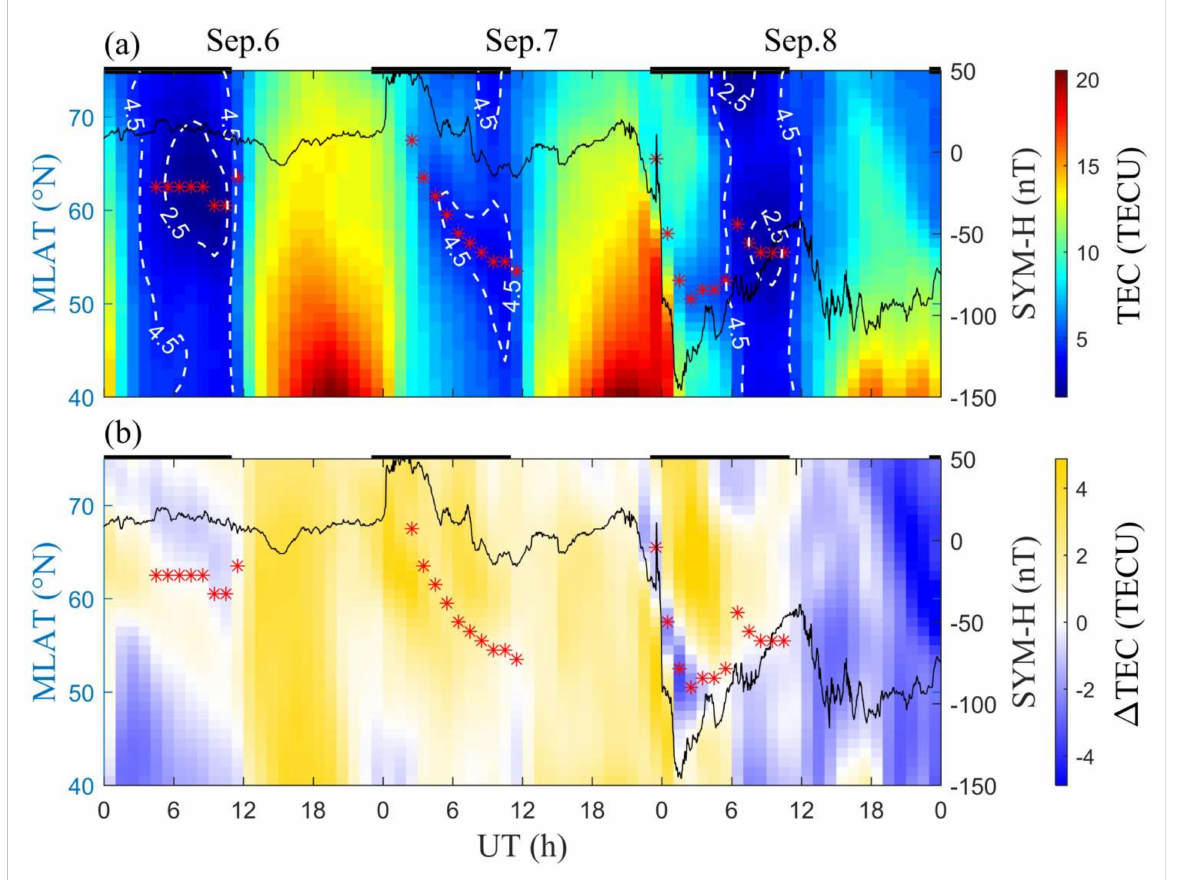
Figure 5. Ionospheric storm variations of ( a ) TEC and ( b ) TEC absolute deviations from the reference for the American sector during the 2017 September storm. The contour levels indicate the 2.5 and 4.5 TECU values. The red asterisks indicate the mid-latitude trough position. The black line shows the SYM-H variations. The local nighttime in the American sector is marked with thick black line